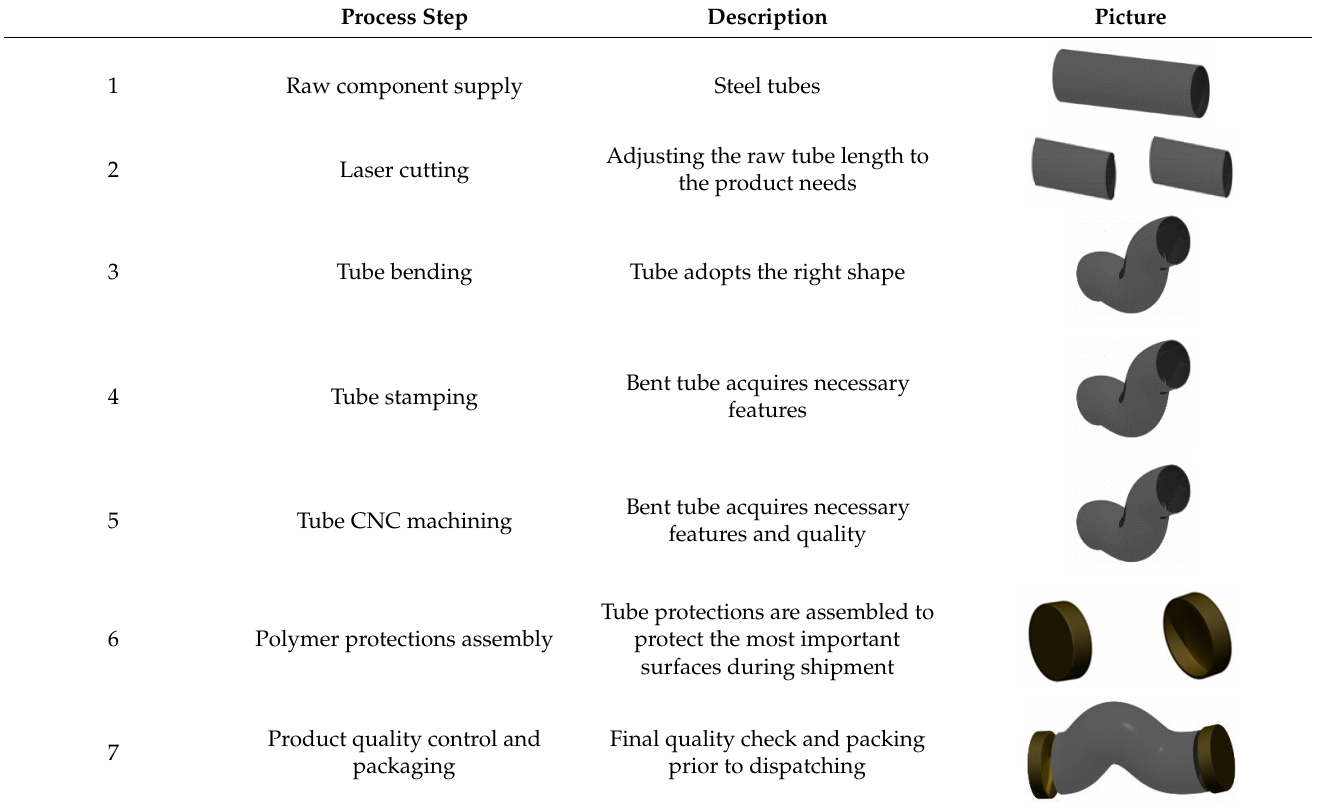
Table 17. Manufacturing process description for the concerned product (Figure